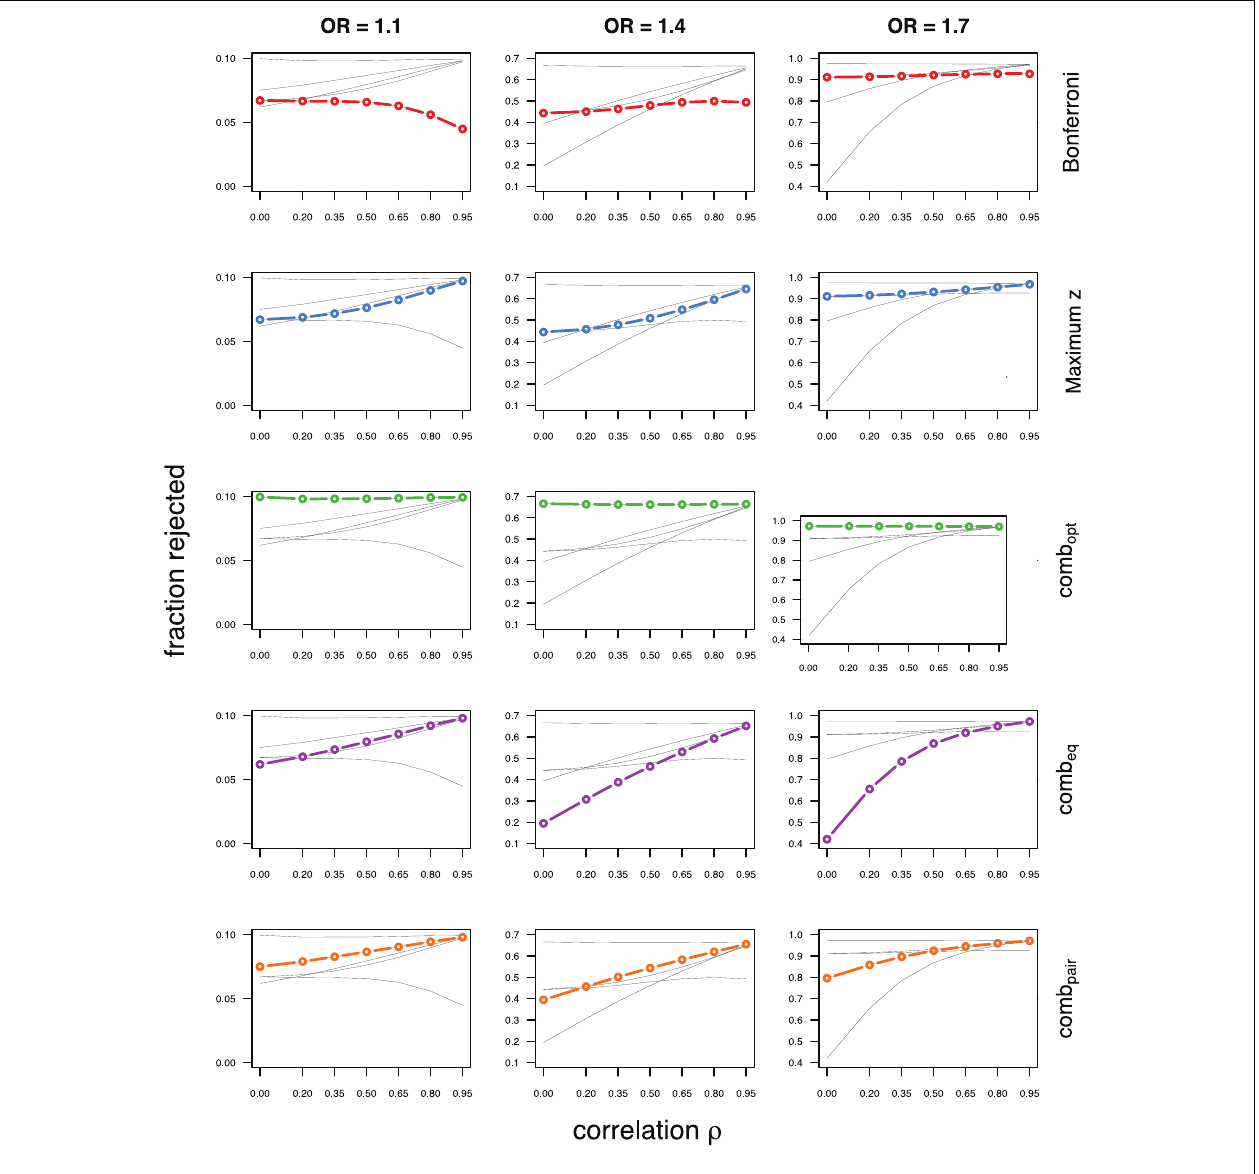
FIGURE 2 | Comparing analytic strategies in the setting with compound symmetry correlation structures, assuming equal minor allele frequencies of 5% in a block of 5 markers. The fraction of rejected null hypotheses of no association (power, y-axis) in 50,000